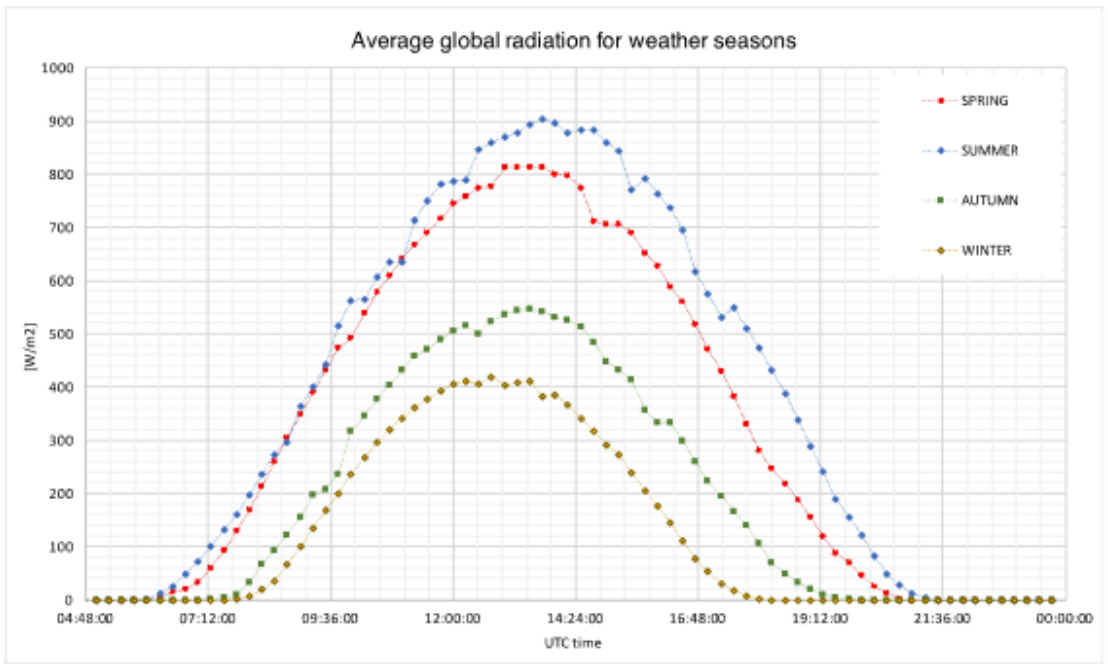
Figure 16. Trend of average global radiation during the day for different weather seasons. The time values were obtained as averages of radiation values for the clearest and sunniest days of each month.